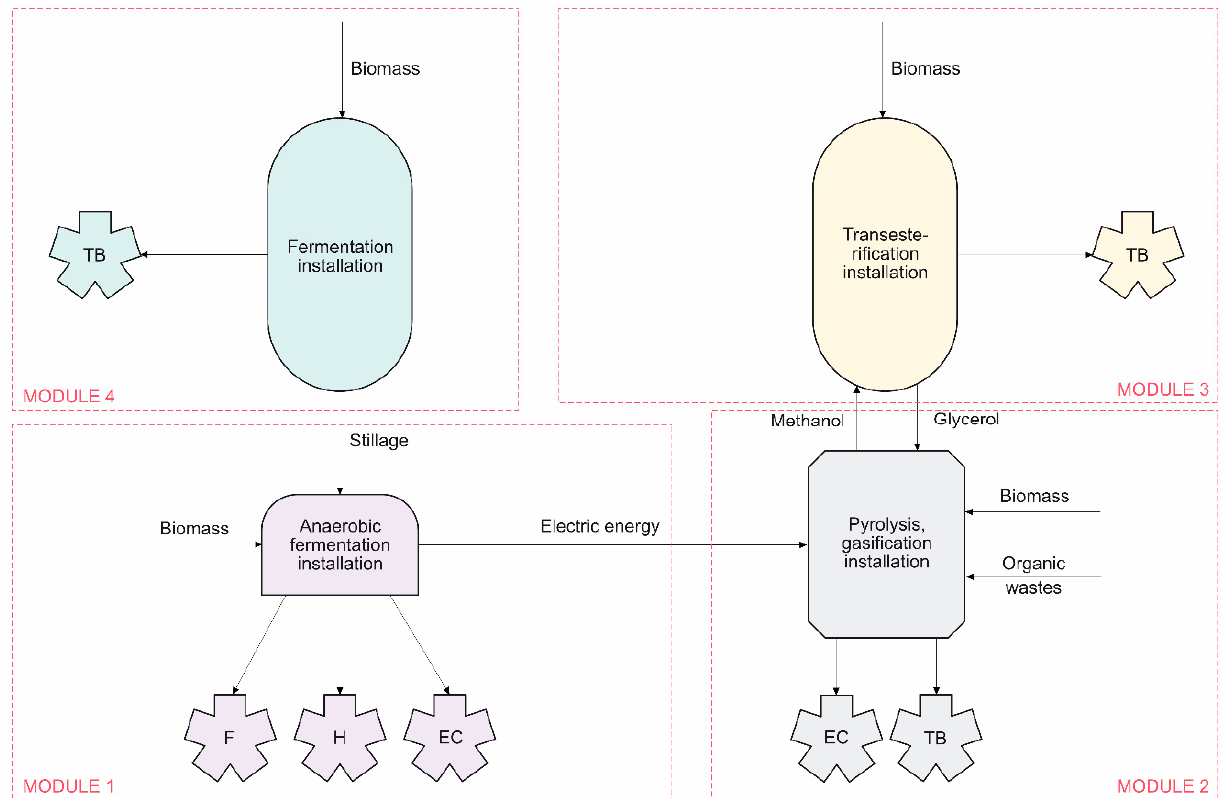
Figure 10. Example of the four-module biomass refinery plant at the Institute of Technology and Life Sciences—National Research Institute (Poznan, Poland). TB—transport biofuel; F—fertiliser; H—heat; EC—energy